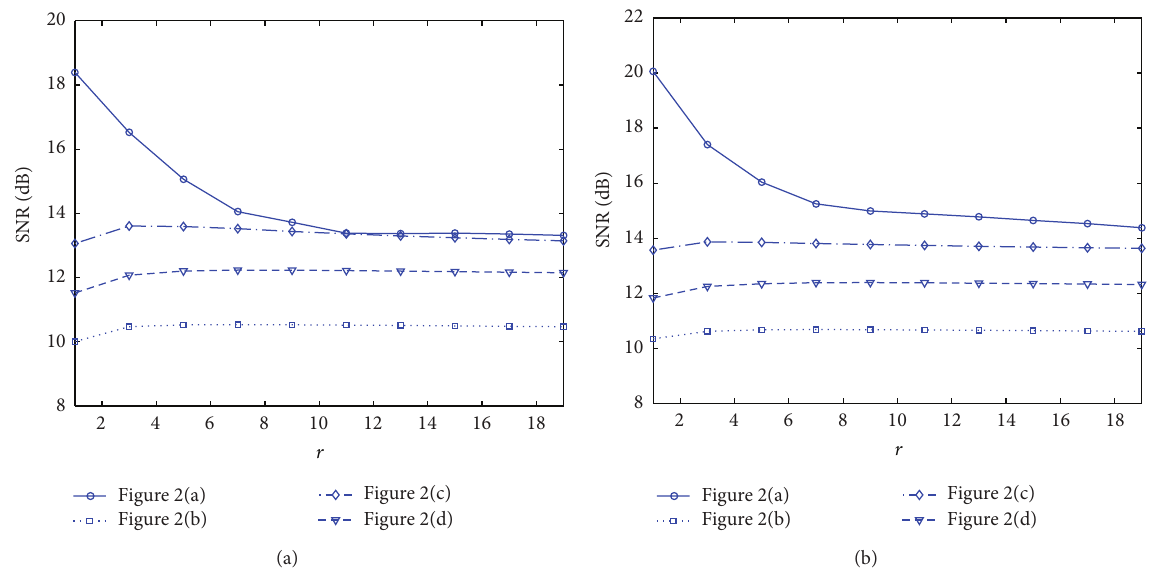
Figure 11: SNR for results restored by our models with different window size 𝑟 : (a) Model 1 and (b) Model 2.